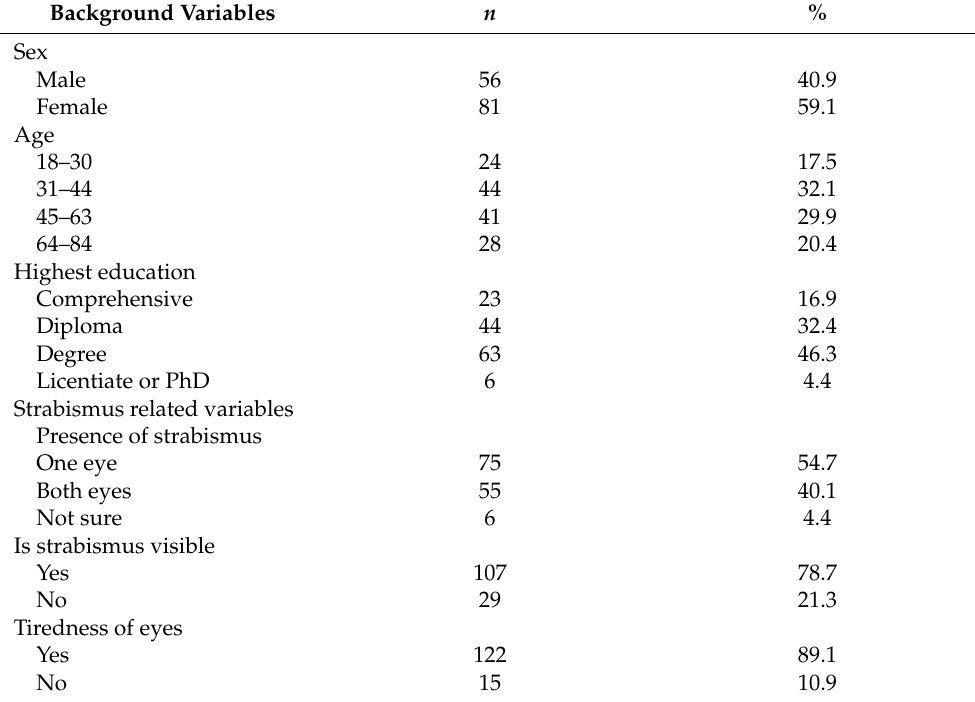
Table 1. The participants’ self-reported characteristics, n =